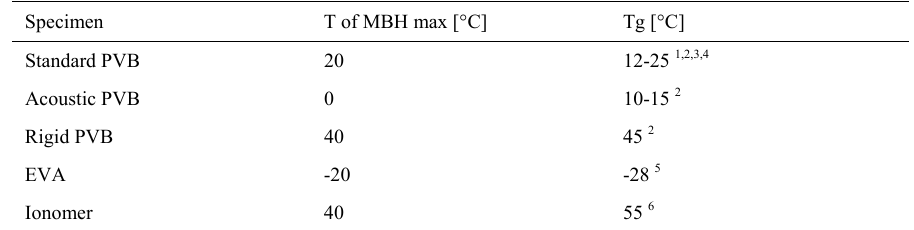
Table 1: Temperature of maximal Mean Break Height and Glass transition temperature of tested interlayers